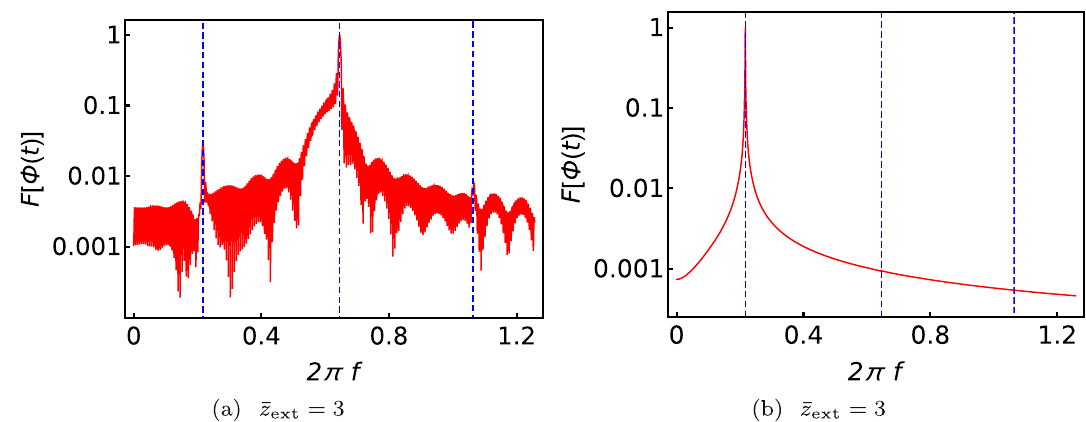
Fig. 6 Left panel: Discrete Fourier transform in time vs. frequency for the evolution of the nonresonance with ¯ m 2 = 0 . 36 for ¯ b = 15. Right panel: Discrete Fourier transform in time vs. frequency for the evolution of the first resonance with ¯ m 2 correspond to the frequencies of the first three odd parity resonances